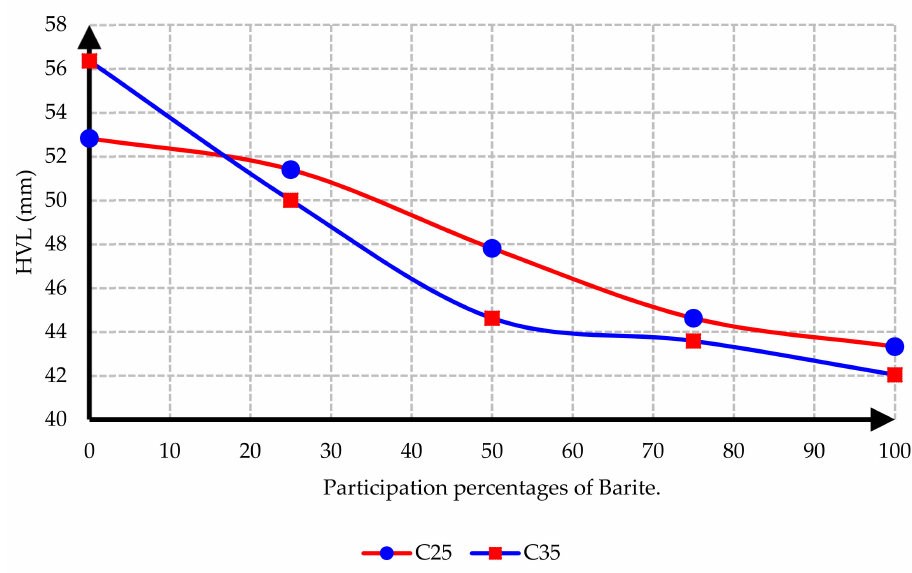
Figure 16. Comparison of HVL thicknesses in C25 and C35 concretes with different proportions of barite.